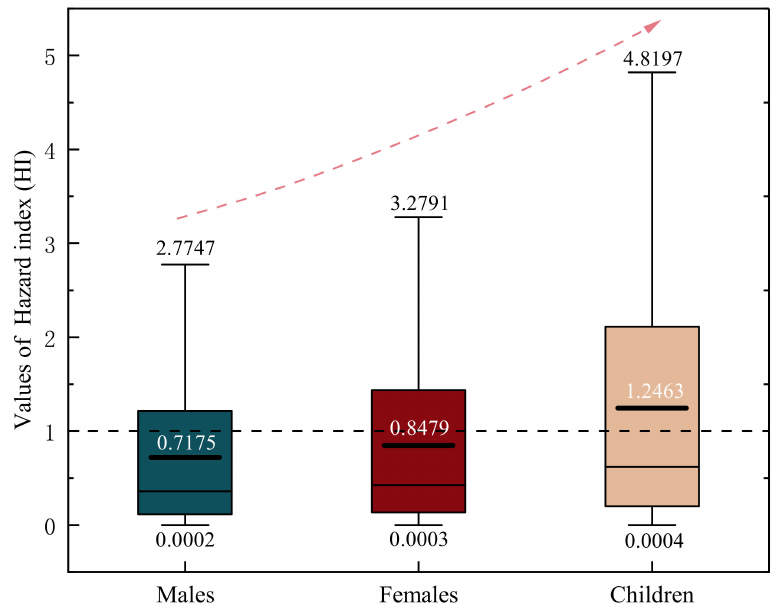
Figure 9. Diagram for non-carcinogenic risks for children, females and males. The red dashed line indicates the trend of increasing health risk Children > Females > Males. The thick black line in the middle of the box is the mean, and the 75th and 25th percentiles are shown on the square horizontal line and the horizontal line below the box,